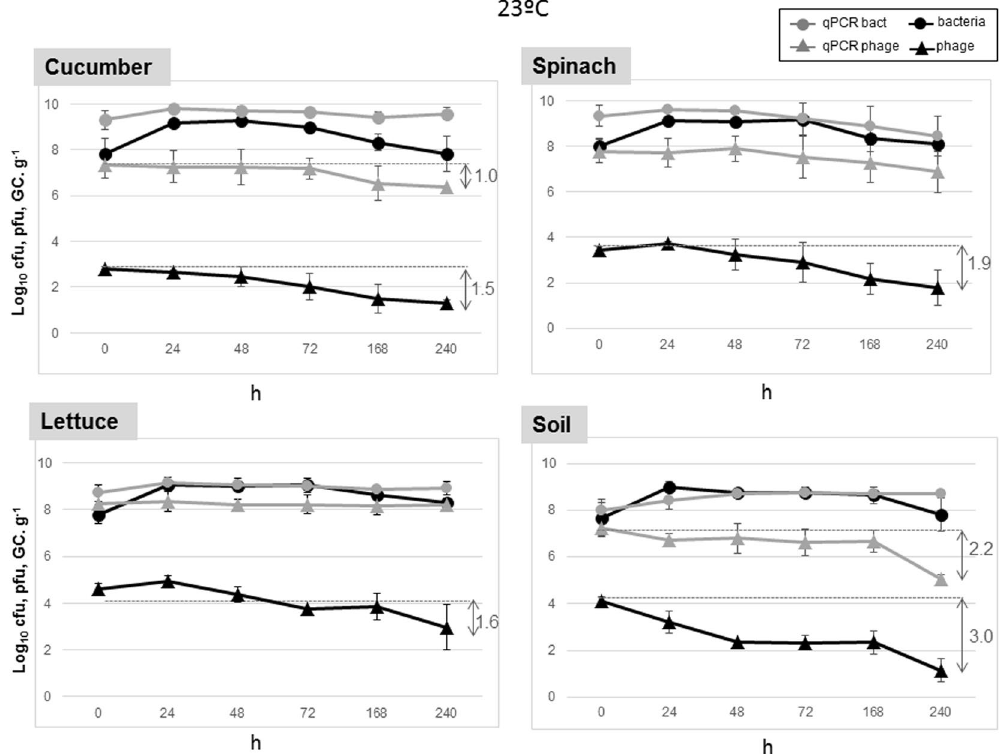
Figure 3. Stability of 933W and E . coli C600 (933W ∆ stx :: gfp - cat ) after 10 days of storage at 23 °C in the different matrices (cucumber, spinach, lettuce, and soil). Values for culturable bacteria are expressed in log 10 cfu.g − 1 . Infectious phages were evaluated by plaque blot and values expressed as log 10 pfu g − 1 . Phage and bacterial genomes were evaluated by qPCR with the stx qPCR assay and the gfp qPCR assay, respectively, and the results are expressed as log 10 GC.g − 1 . All results are the mean of three independent experiments. Those microorganisms showing significant ( P < 0.05) reductions are indicated by a vertical